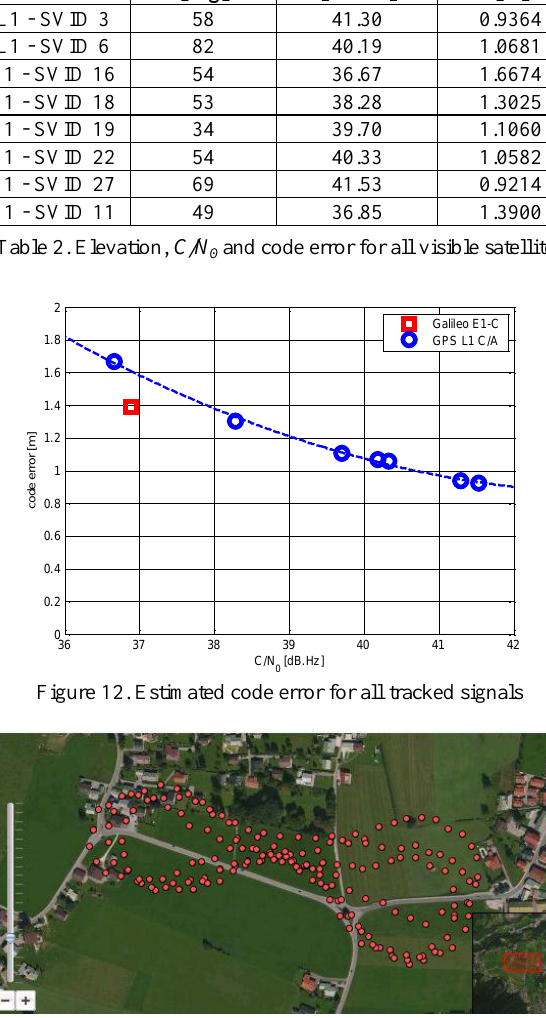
Figure 13. Estimated position during flight